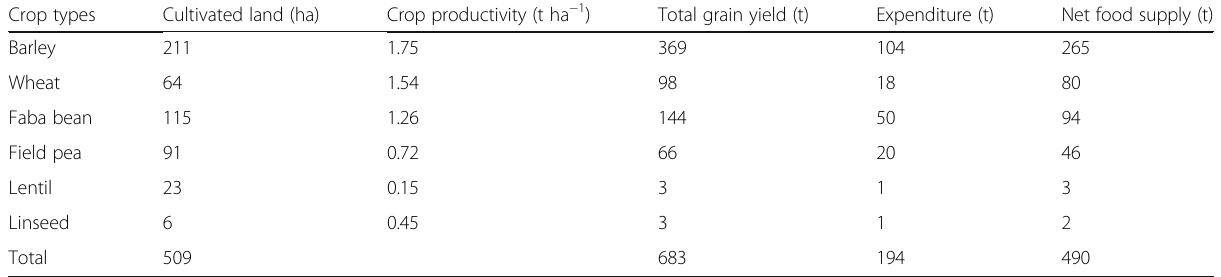
Table 2 Crop production, expenditure, and net food supply in 2015/2016 cropping season Crop types